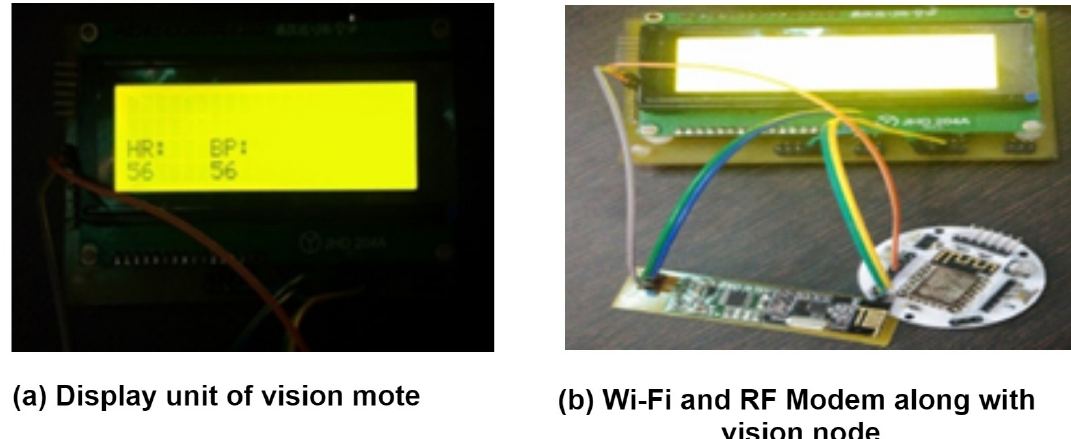
Figure 6. Real-time value in vision mote.